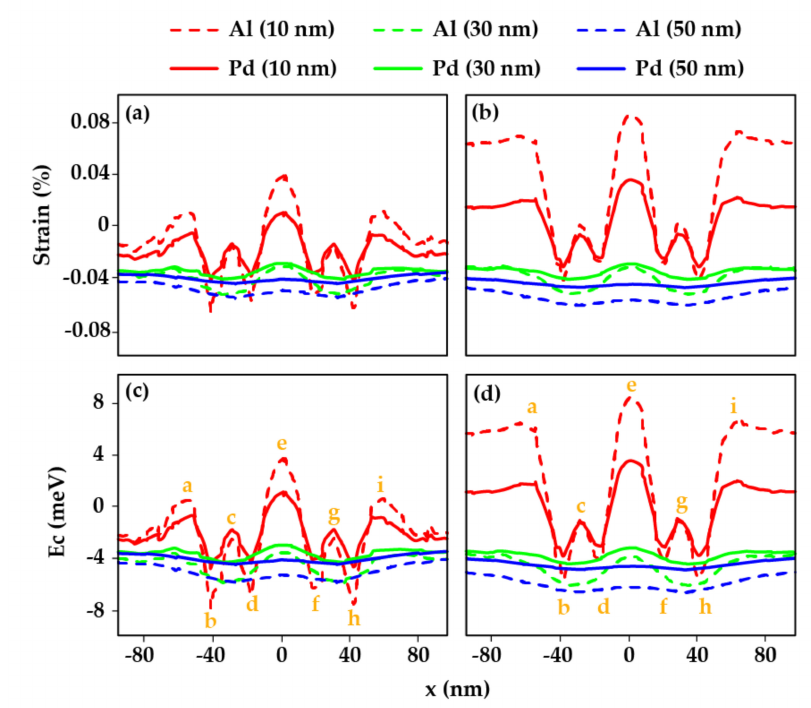
Figure 4. ( a , b ) Strain ∈ z comparison of Al vs Pd gates on Si-bulk at the SiO 2 thickness of 10 nm, 30 nm and 50 nm for Figure 1a,b models respectively. ( c , d ) Calculated conduction bands for Al vs Pd based on ( a , b ) simulated strain results respectively at the SiO 2 thickness of 10 nm, 30 nm and 50 nm. The peaks and valleys of the conduction bands are indicated by a – i (in orange) to calculate the average change in conduction bands due to CTE